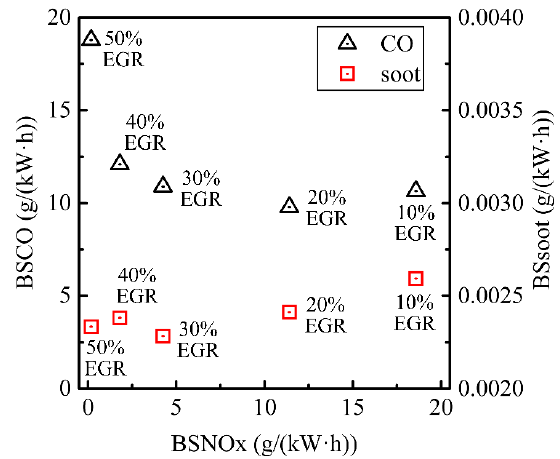
Figure 16. BSCO–BSNOx trend and BSsoot–BSNOx trend for the CDAc + EGR mode with the EGR rate from 0% to 50% at an engine speed of 450 rpm and an engine load of 1000 N ∙ m (the emission results were transformed from 3D simulation of ESE DIESEL).